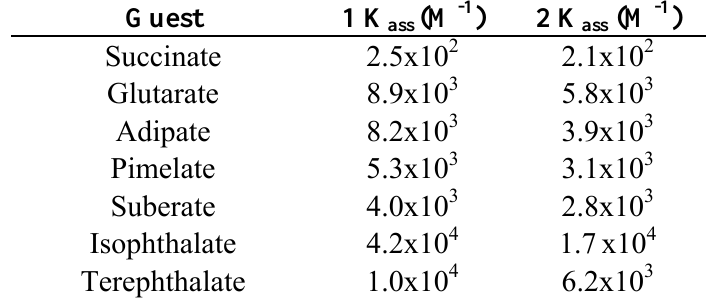
/DMSO-d (4%). In all cases 1:1 receptor:anion stoichiometry was 3 6